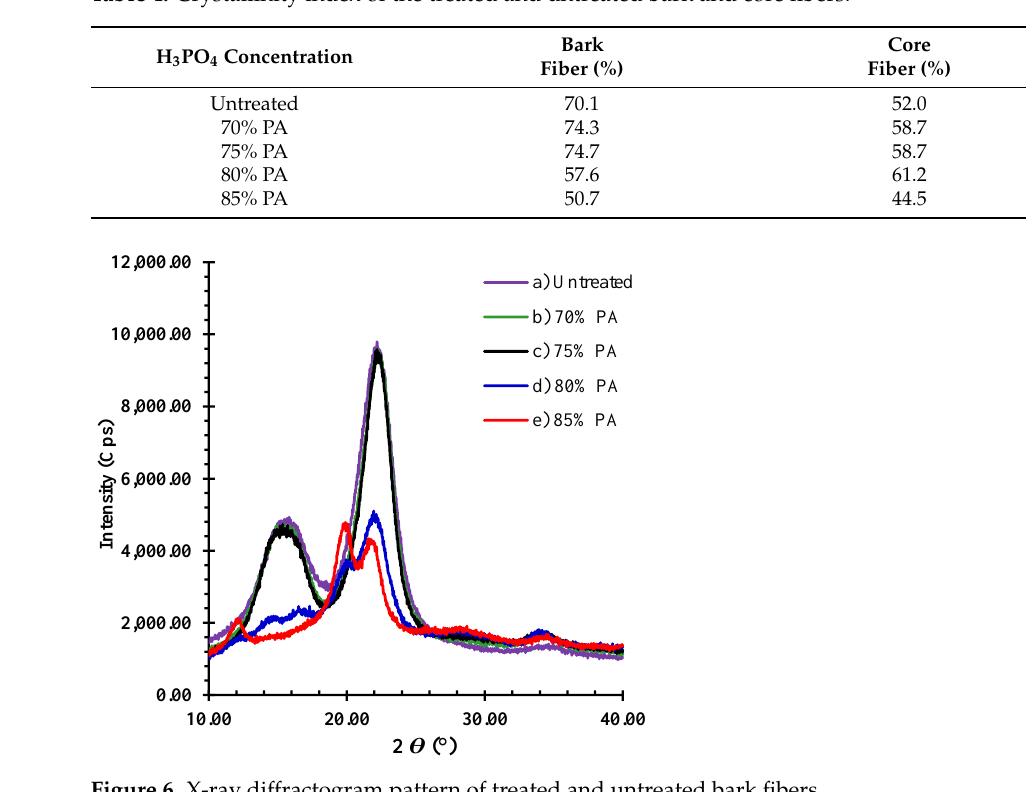
Table 4. Crystallinity index of the treated and untreated bark and core fibers.